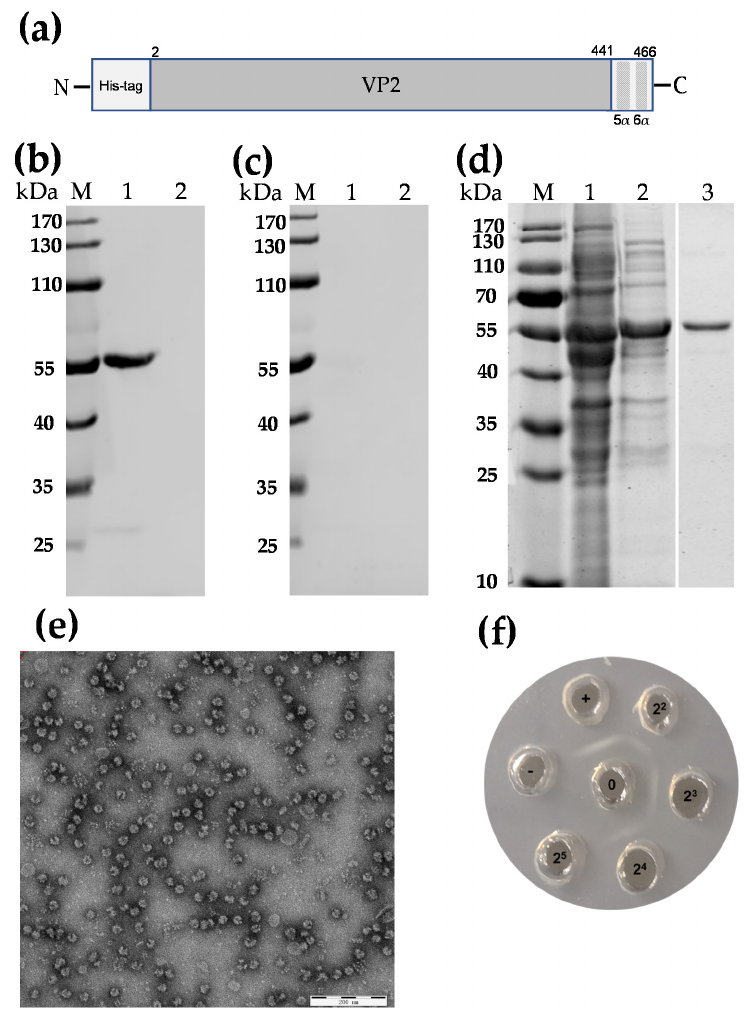
Figure 1. Preparation and identification of SHG19-VLP. ( a ) The Schematic diagram of the recombinant protein SHG19-VP2-466 (not drawn to scale). The SHG19-VP2-466 protein is a truncated pVP2 (amino acids [aa] 2-466) fusing with a N-terminal His-tag containing an initiation codon (ATG); VP2: aa 2-441 of pVP2; 5 α : 5 α -helix (aa 443-452 of pVP2); 6 α : 6 α -helix (aa 456-462 of pVP2); ( b ) Western blotting of the fusion protein SHG19-VP2-466 with an anti-VP2 monoclonal antibody (7D4). Lane M: Marker; Lane 1: the SHG19-VP2-466 in the supernatant of the pCo-HHT28-SHGVP2-466-transformed E. coli ; Lane 2: supernatant of the pCold I-transformed E. coli ; ( c ) Western blotting of the fusion protein SHG19-VP2-466 with an anti-Flag monoclonal antibody. Lane M: Marker; Lane 1: the SHG19-VP2-466 in the supernatant of the pCo-HHT28-SHGVP2-466- transformed E. coli ; Lane 2: supernatant of the pCold I-transformed E. coli ; ( d ) SDS-PAGE analysis of the fusion protein SHG19-VP2-466. Lane M: Marker; Lane 1: the fusion protein SHG19-VP2-466 protein sample; Lane 2: the purification of the fusion protein SHG19-VP2-466 via ammonium sulfate precipitation; Lane 3: the purification product of the fusion protein SHG19-VP2-466 via size-exclusion chromatography; ( e ) TEM image of the purified protein SHG19-VP2-466 (named SHG19-VLP). ( f ) AGP analysis of SHG19-VLP. 0: Antiserum; +: antigen of IBDV; -: PBS as a control; 2 2 –2 5 : dilution ratio of